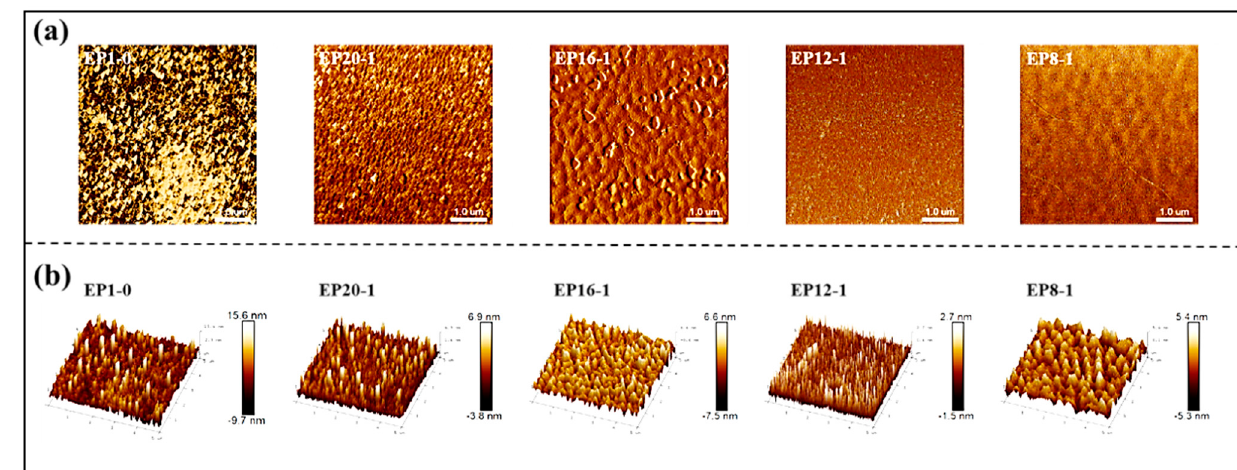
Figure 11. AFM 2D phase images ( a ) and 3D height images ( b ) of EPx samples.